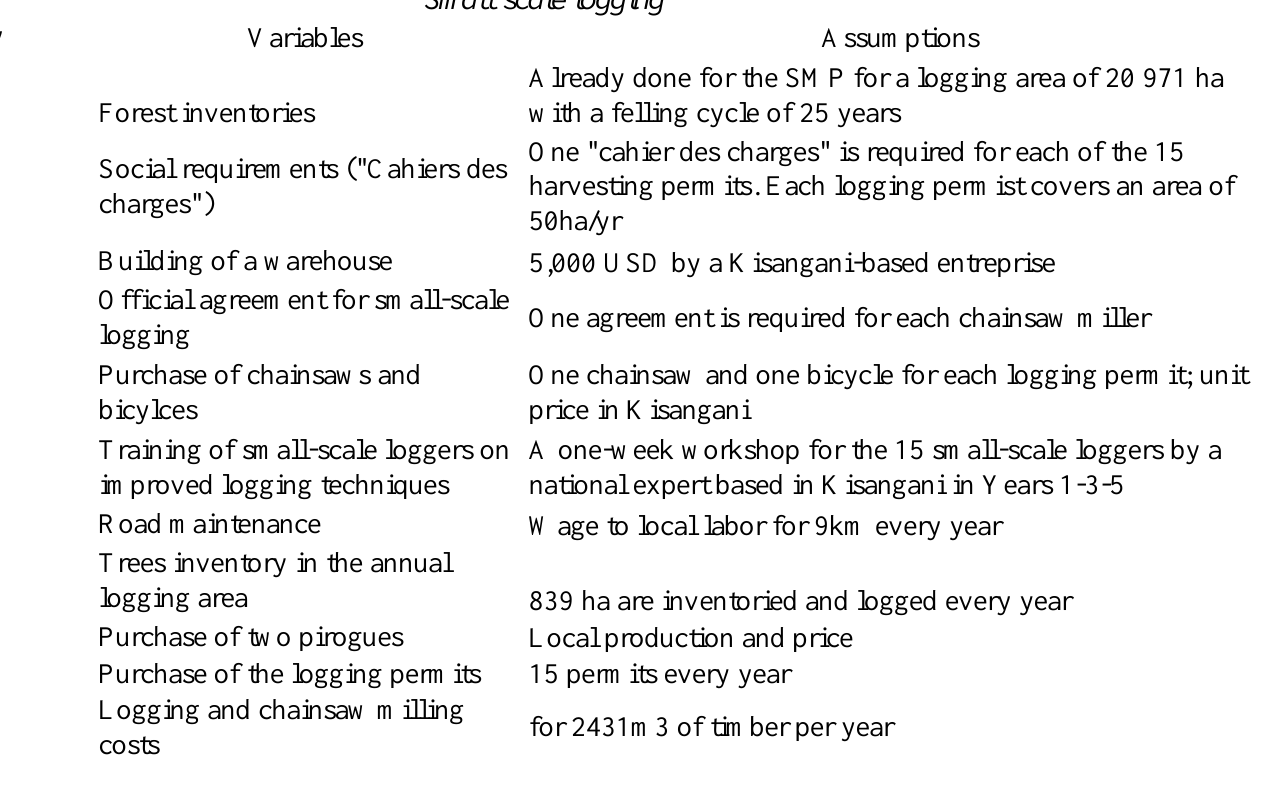
Table A1.2: Variables and assumptions used for the cost-benefit analysis of the LCFC of Uma Surface area